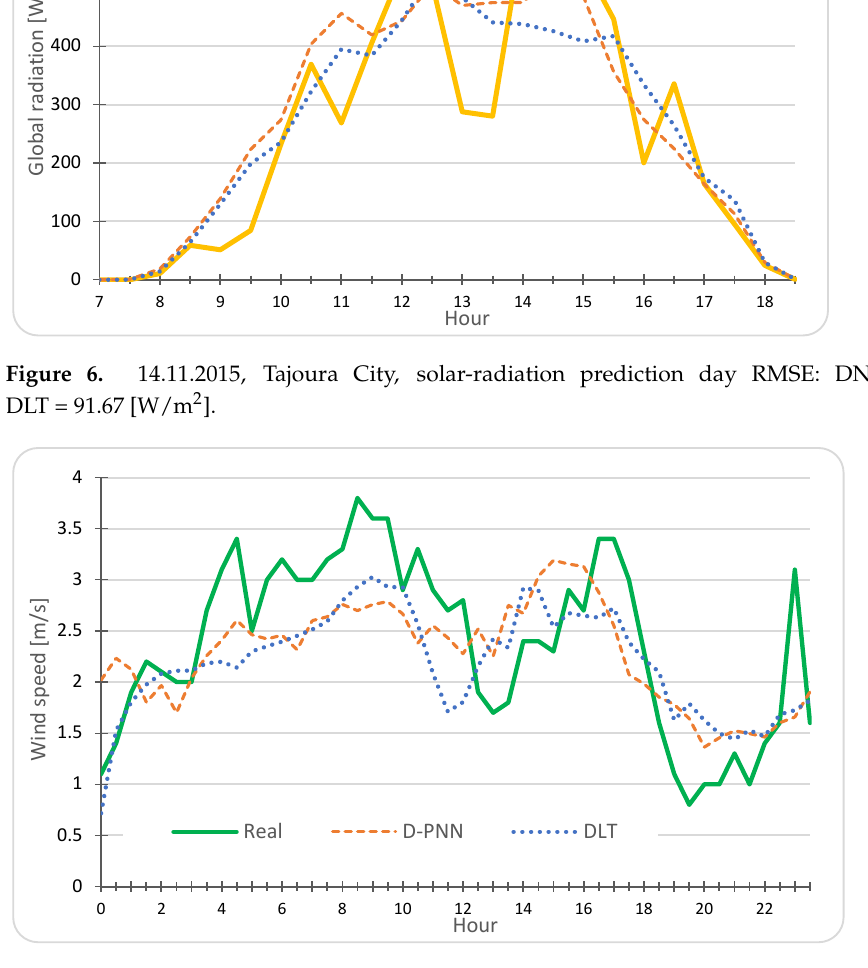
Figure 7. 14.11.2015, Tajoura City, wind-speed prediction day RMSE: DNN = 0.618, DLT = 0.598 [m/s].